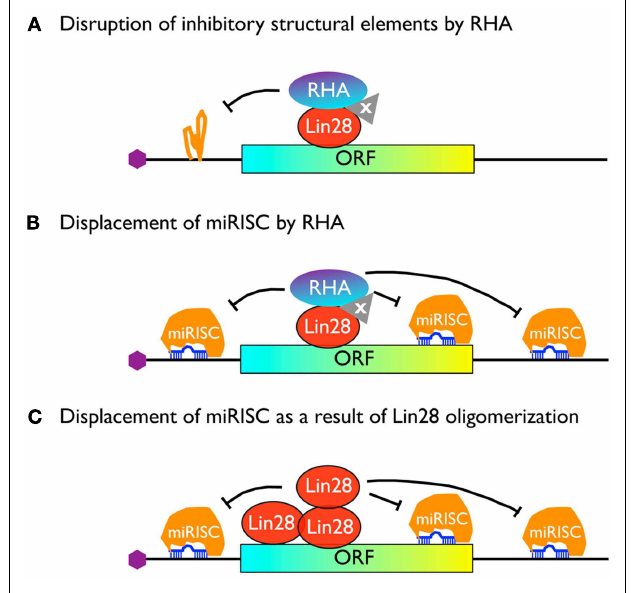
FIGURE 3 | Model for Lin28-mediated stimulation of translation.